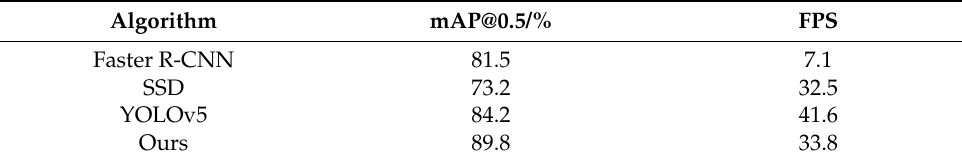
Table 4. Comparison and detection results of each algorithm.